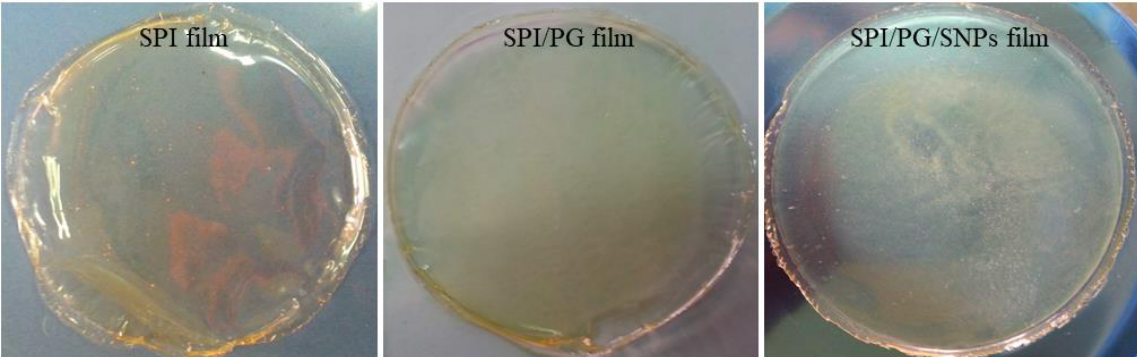
Figure 1. Appearance of SPI-based films containing persian gum (PG) and silver nanoparticles